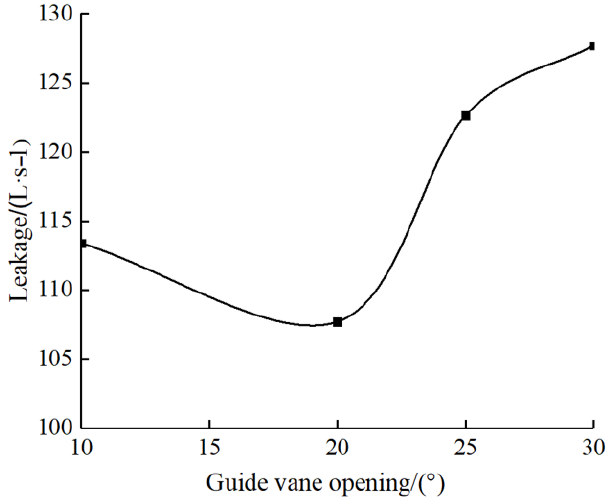
Figure 11. Leakage in band clearance under different guide vane opening.